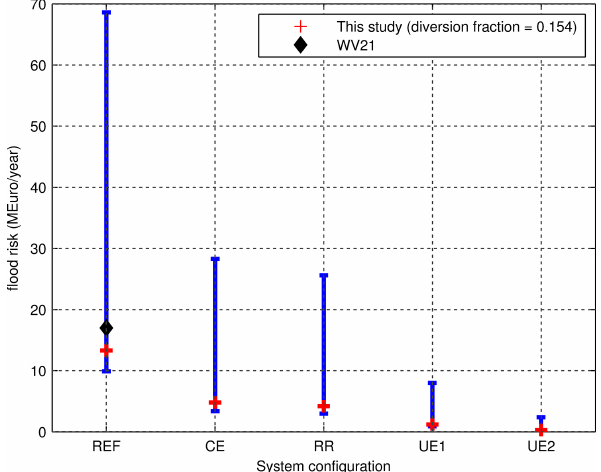
Figure 4. Flood probability of reference system and alternative con- figurations with uncertainty bounds reflecting the different diver- sion fractions.